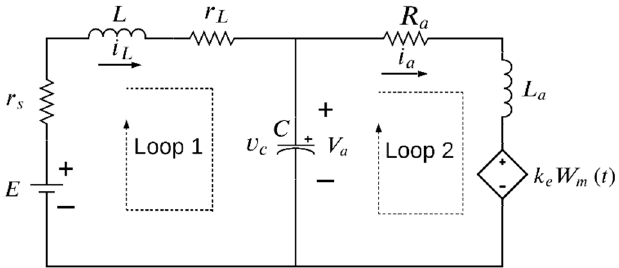
Figure 3. Model of the buck-motor system with the switch S closed.